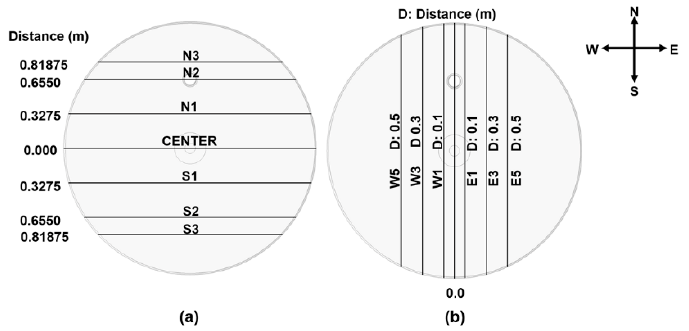
Figure 3. ( a ) Planes examined in the mathematical model in the North and South sectors. ( b ) Planes in the East and West sectors. Numbers in the planes indicate their distances from the plane of symmetry of Center plane.